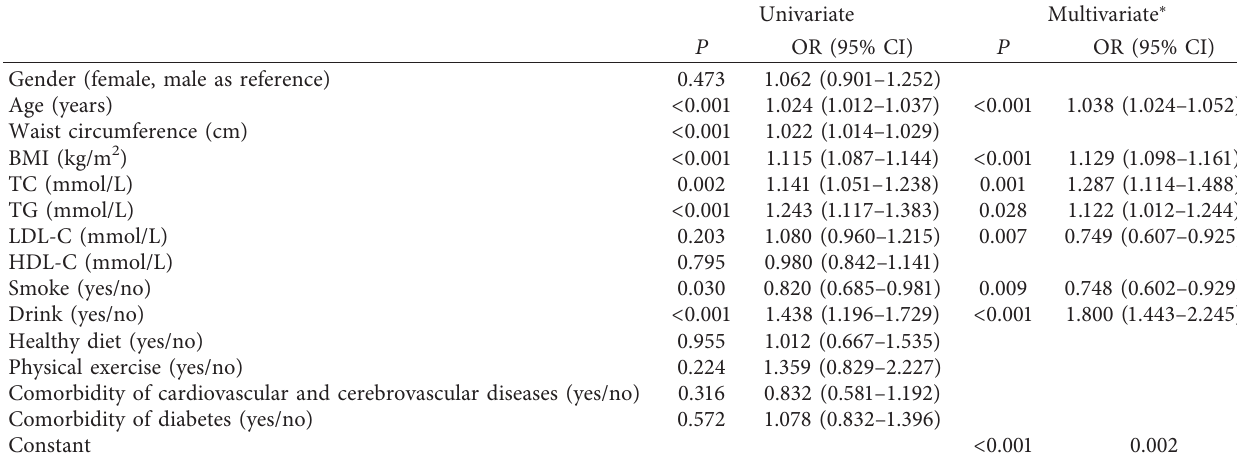
Table 2: Binary logistic results of variables with hypertension in the population without awareness hypertension.